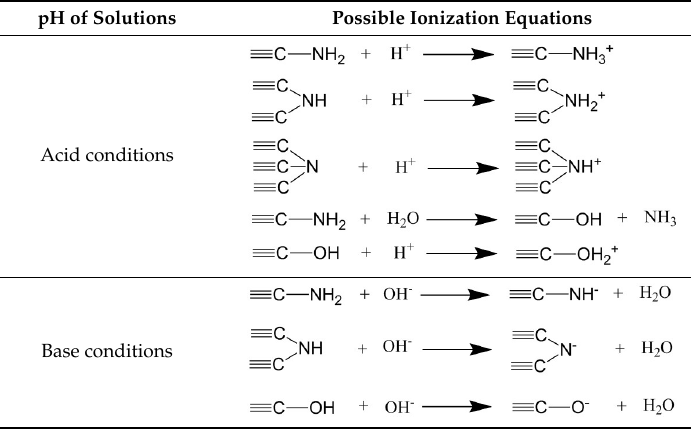
Figure 10. Effect of pH on the catechol removal rate. Table 4. Equations of the ionization of amine groups on the g-C 3 N 4 /Fe 3 O 4 surface in an aqueous suspension [26,35,36].